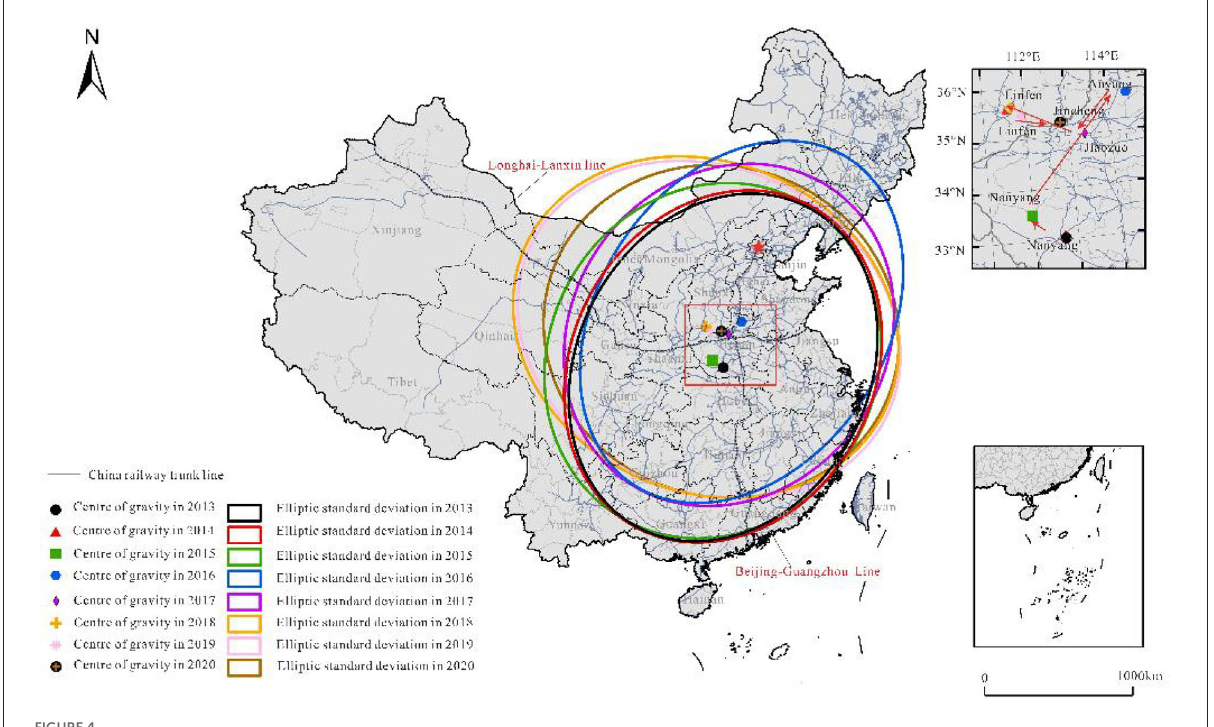
FIGURE4 Shift of center of gravity of China’s railway container